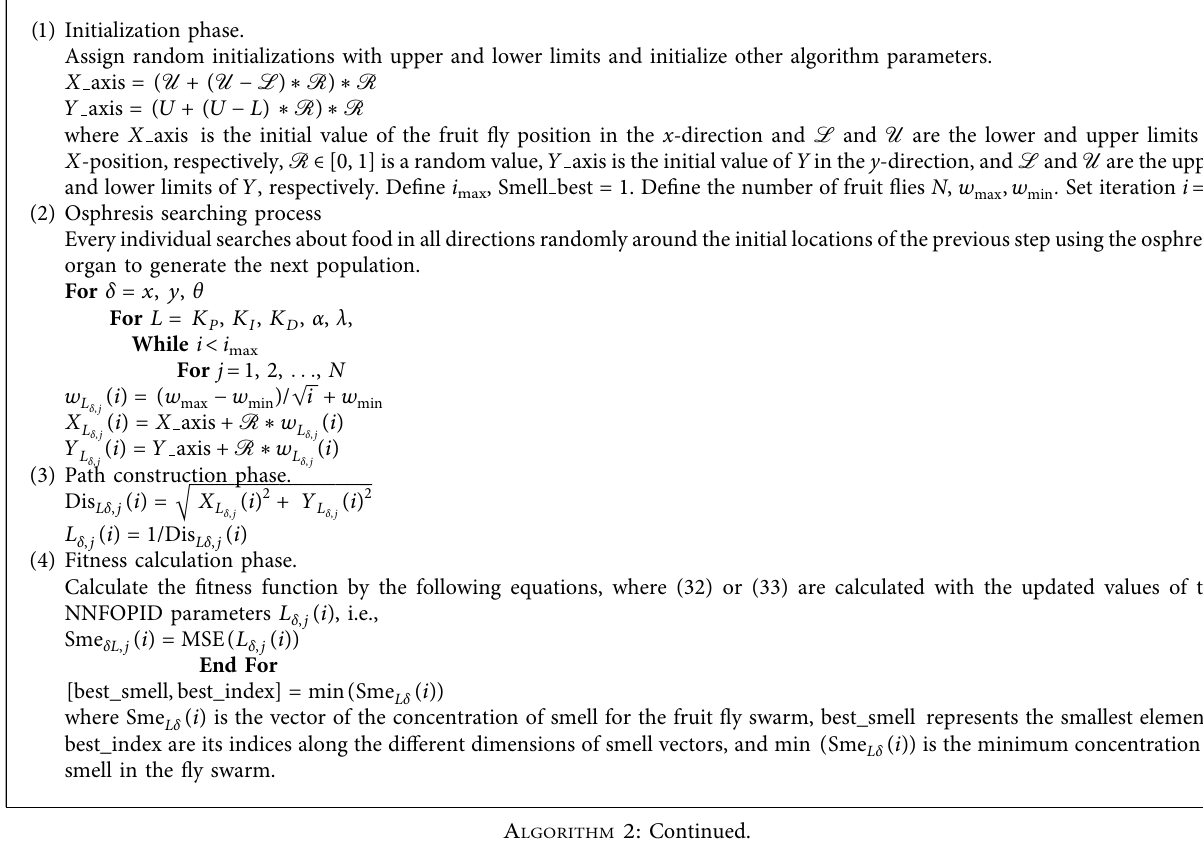
(1) Initialization